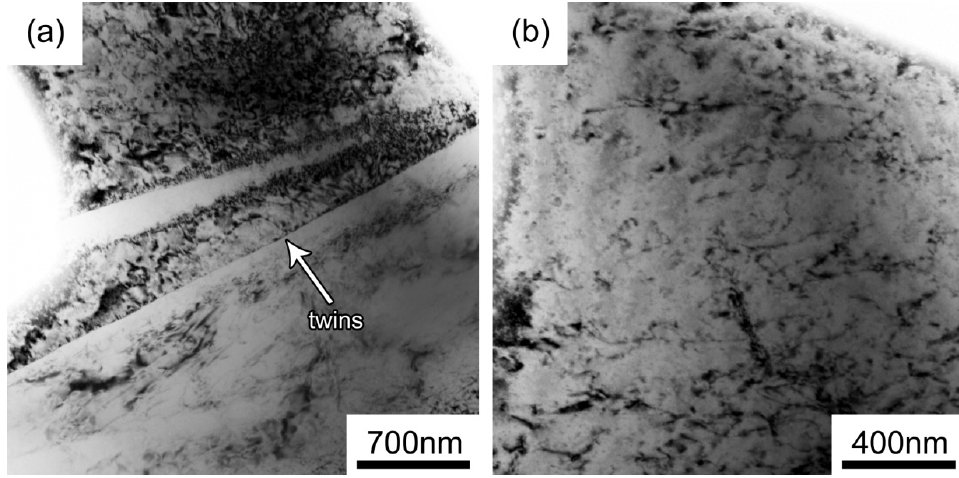
Figure 4. TEM bright-field images of the quenched specimen with 8% pre-stretching: ( a ) twins; ( b ) dislocations.